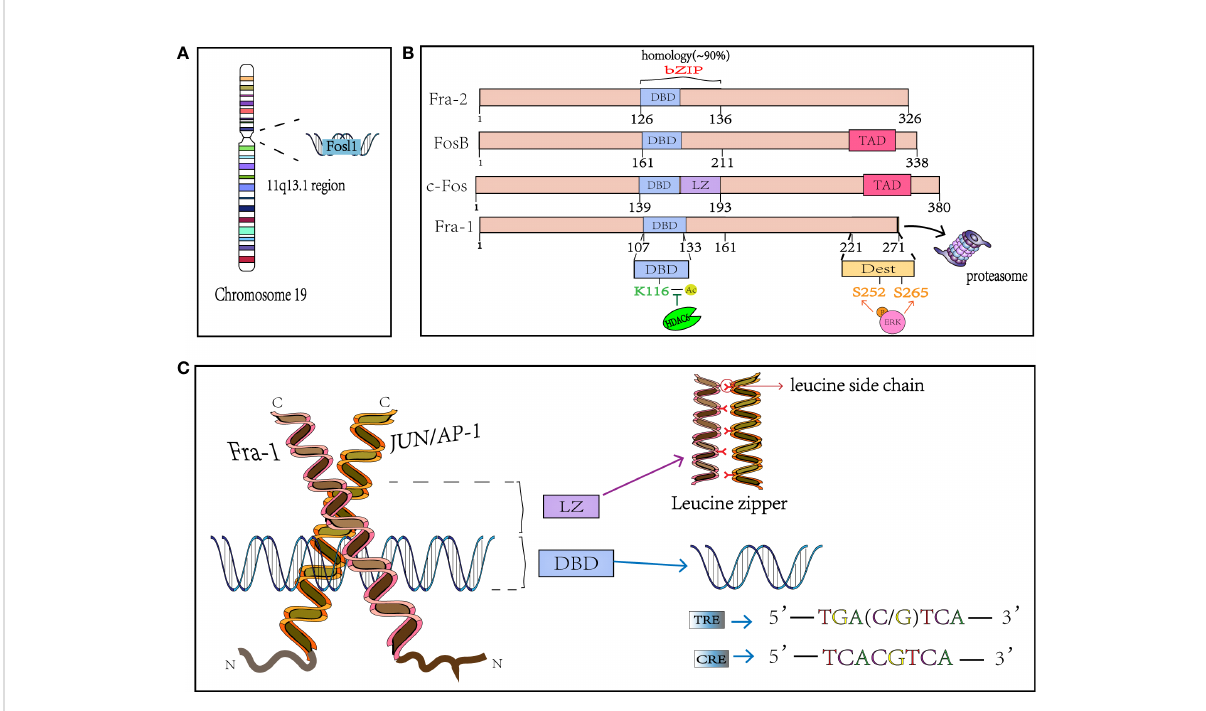
FIGURE 1 The structure of Fra-1. (A) FOSL1 is on chromosome 19 and located in the 11q13.1. (B) Schematical presentation of the structure of FOS mambers. bZIP, basic Leucine zipper region for dimerisation and DNA-binding and the FOS family has 90% homology in this region; The phosphation of Fra-1 at side S252 and S265 inhibits the COOH-terminal destabilizer increasing Fra-1 half-time and the K116 deacetylation positively controls DNA binding and transactivation. DBD, DNA binding domain; LZ, leucine zipper; TAD, C-terminal transactivating domain. DEST, destabilizer element; HDAC6, Histone deacetylase 6. (C) X-ray structure of the bZIP dimmer AP-1 bound to DNA; Fra-1 and Jun preferentially binds to the DNA motif known as the TRE and CRE. TRE, TPA reaction element; CRE, cAMP-responsive